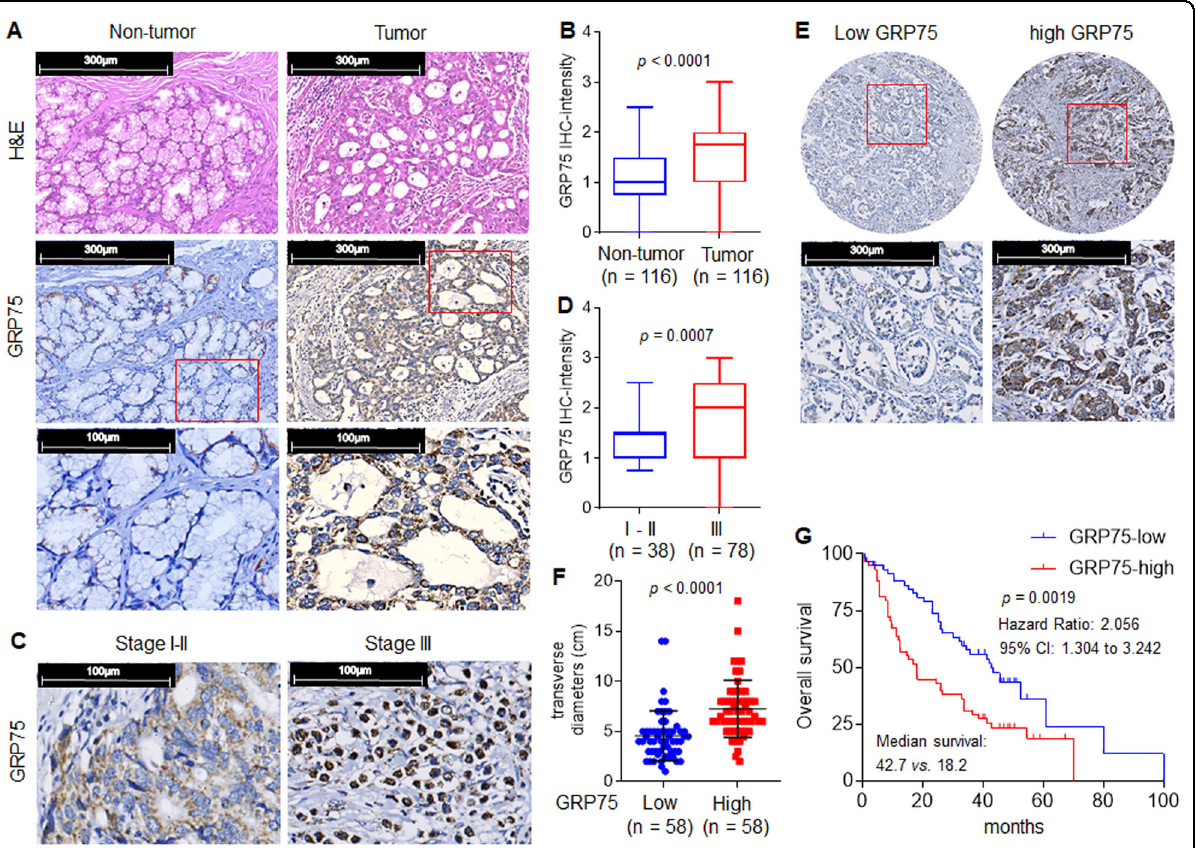
Fig. 6 Identi fi cation of GRP75 as a characteristic cancer-promoting factor and the clinical signi fi cance of GRP75 in GC. A and B H&E, IHC staining, and IHC-intensity of GRP75 in tumors and adjacent tissues. C and D IHC staining and IHC-intensity of GRP75 in different TNM stages. E IHC staining of GRP75 in tumors with low and high levels. F The transverse diameters of tumors in GRP75 low and high groups. G Kaplan-Meier analysis of the prognostic signi fi cances of GRP75 in these